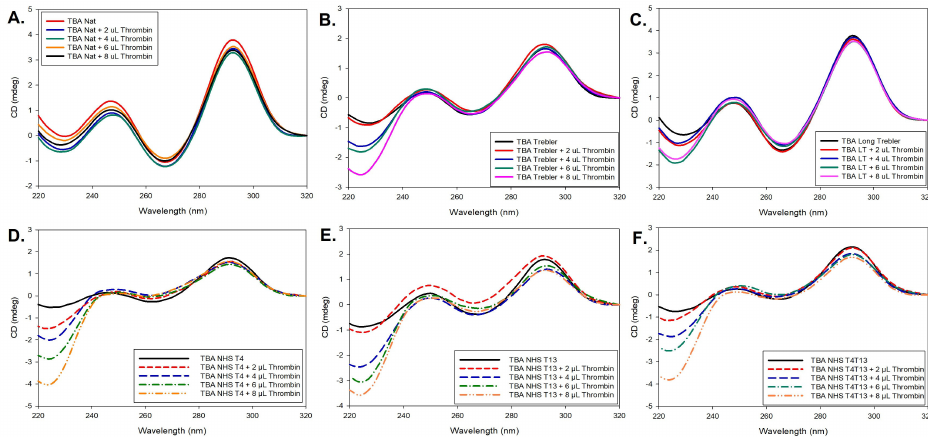
Figure 2. CD spectra of ( A ) TBA, ( B ) 5TG, ( C ) 5LTG, ( D ) 4NHT, ( E ) 13NHT and ( F ) 413NHT titrated with increased equivalence of 100 µ M thrombin